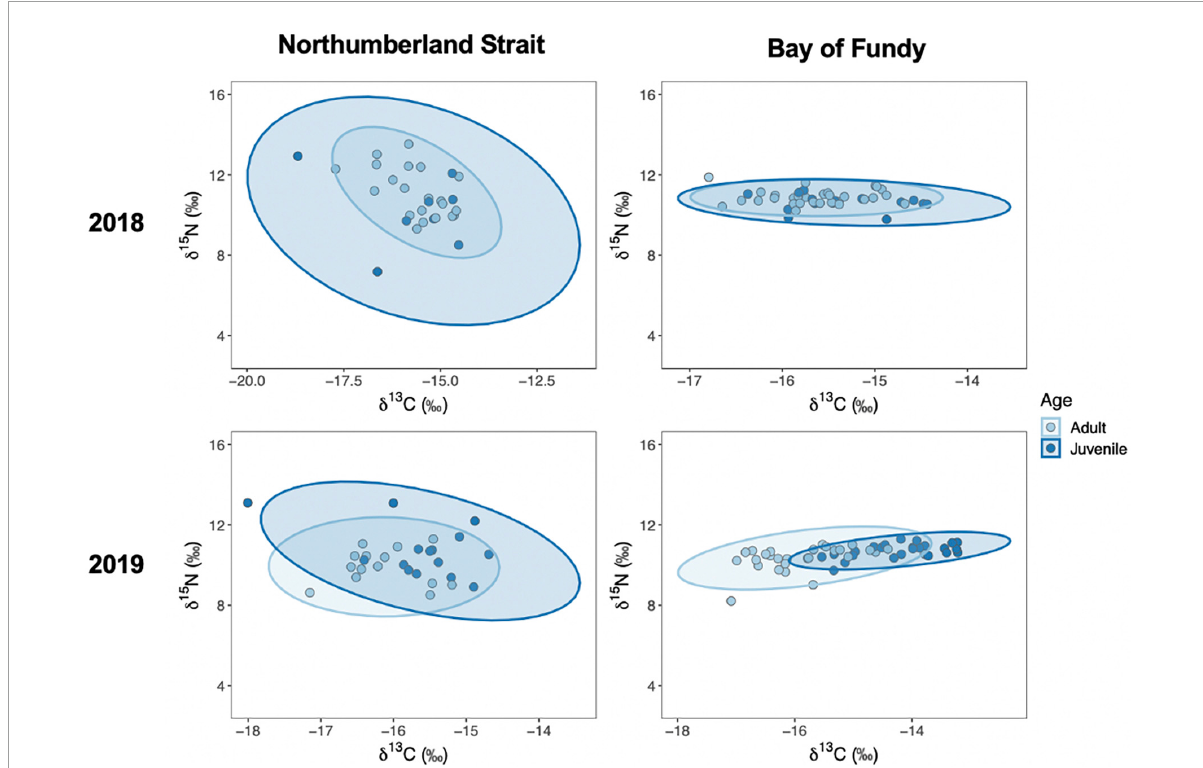
FIGURE3 Isotopic dietary niches of Semipalmated Sandpiper adults (light blue) and juveniles (dark blue) captured at Petit Cap ( left : 2018: N adult = 21, N juvenile = 8, 2019: N adult = 14, N juvenile = 14) and Johnson’s Mills ( right : 2018: N adult = 31, N juvenile = 14, 2019: N adult = 28, N juvenile = 24) in 2018 (top) , and in 2019 (bottom) . Ellipses represent maximum likelihood estimates and were developed using δ 15 N and δ 13 C isotope signatures of blood plasma in parts per